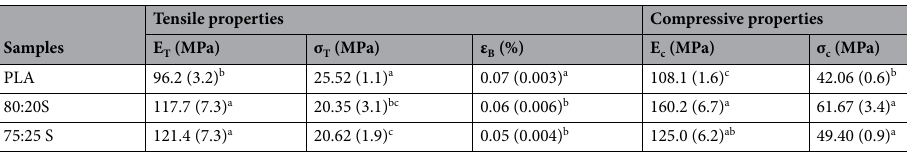
Table 2. Mechanical properties of 3D-printed scaffolds. E T tensile elastic modulus, σ T tensile strength, ε B elongation at break, E